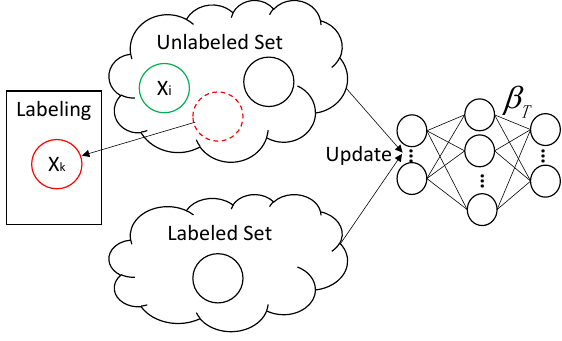
Figure 5. Unlabeled decremental